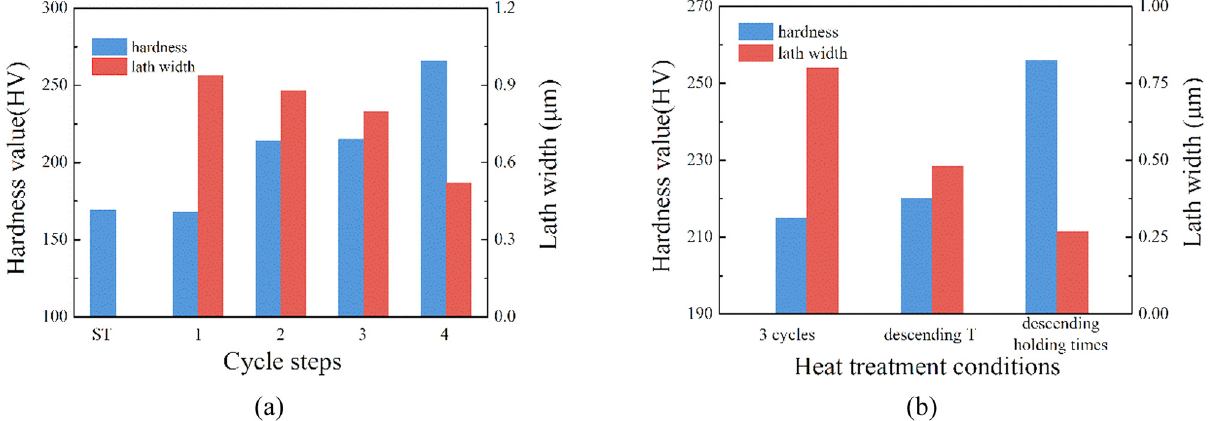
Figure 12: The bulk hardness andlath width of specimen vibrationwith ( a ) cyclesteps and ( b ) thesamethreecyclesteps with di ff erent temperatures and holding